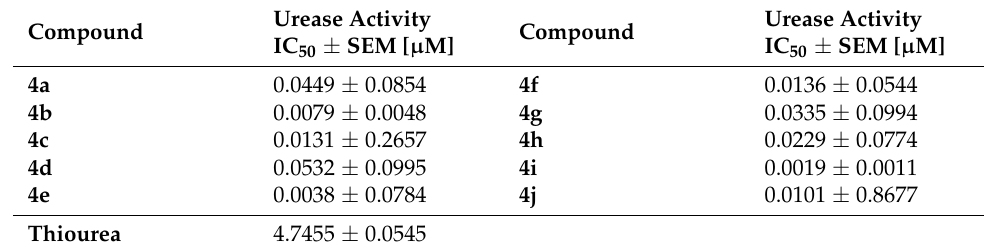
Table 1. Urease inhibitory activity of 1-aroyl-3-[3-chloro-2-methylphenyl]thiourea hybrids 4a – j